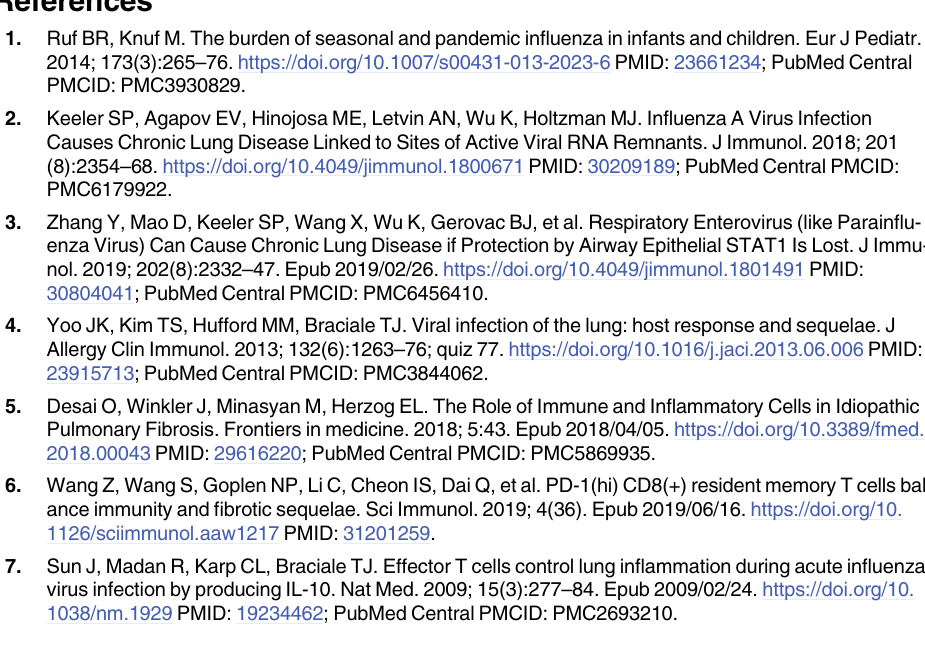
S1 Fig. Pparg is highly expressed in alveolar macrophages compared to epithelial cells.